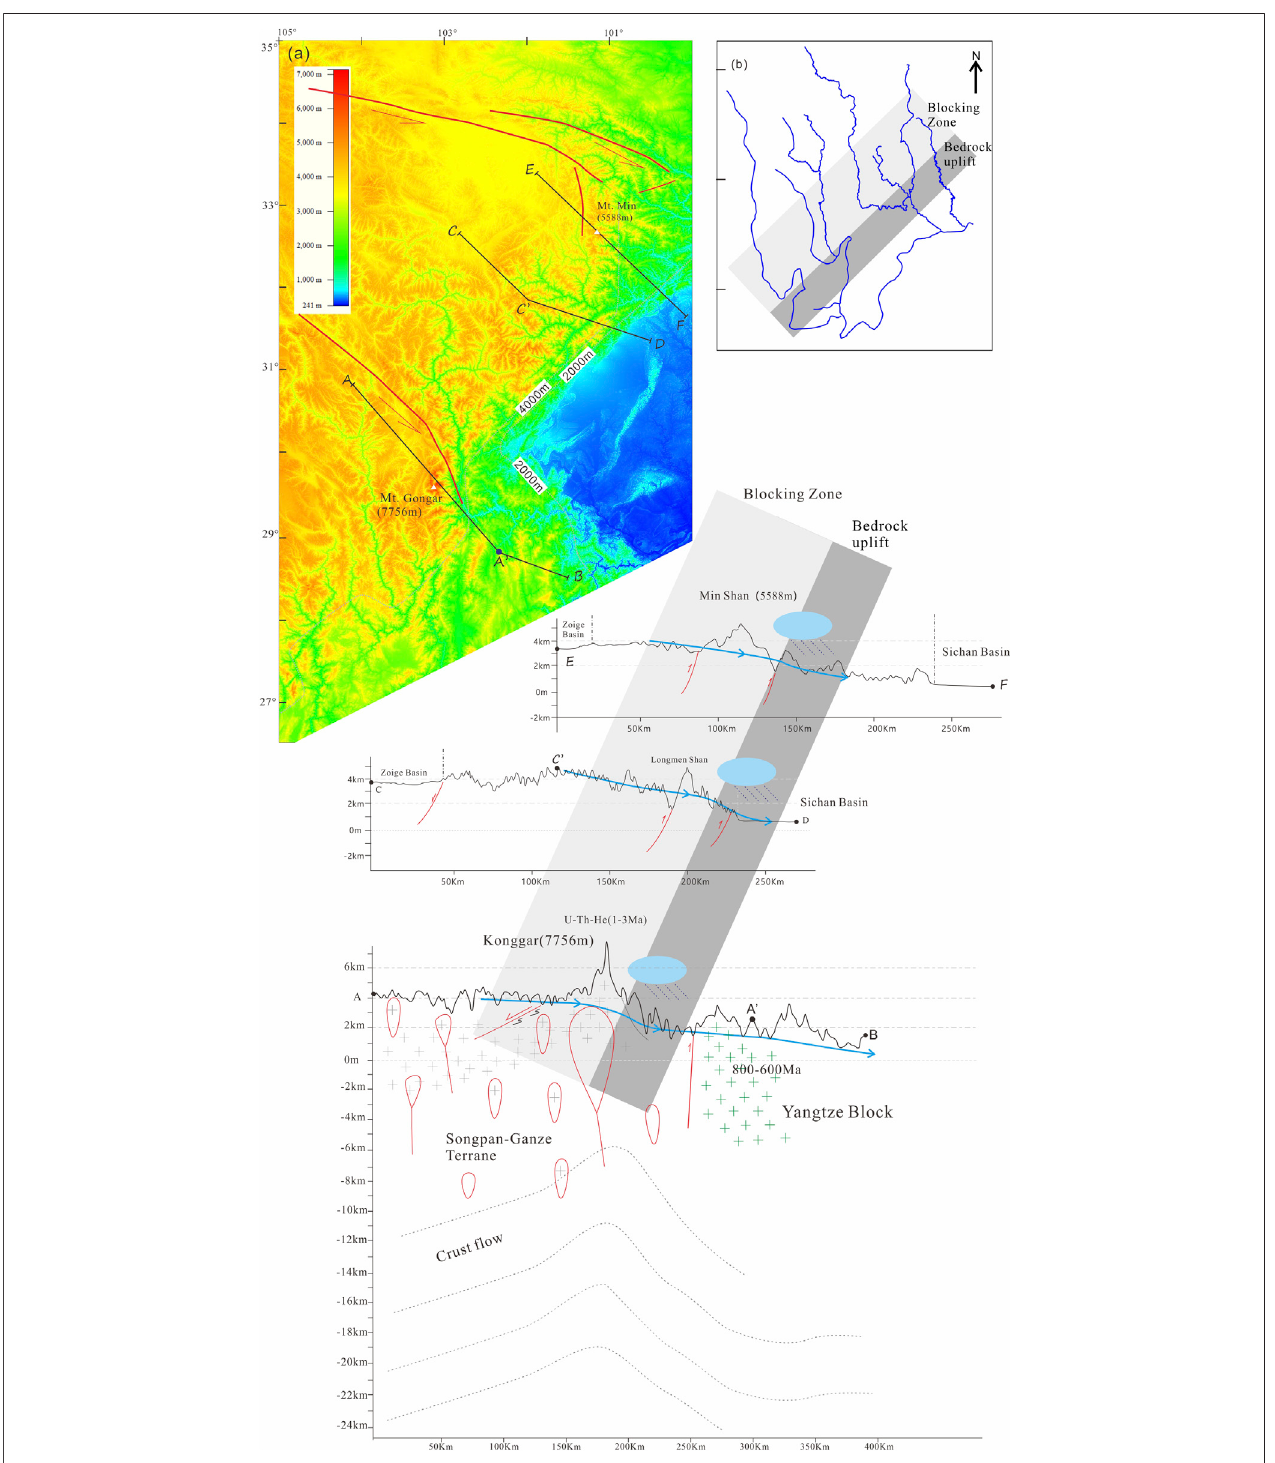
FIGURE7| Landform analysisoftheeastern TibetanPlateau(The map summarizesthecausesofthehigh and steeplandform onthe EastTibet.Theapproximate spatialpositionoftheblocking areaismarkedinthemap. Fromtheperspectiveofexogenicforces,heavy rainfallfrequentlyoccursinthepiedmont oftheeasternmargin of Tibet Plateau, which speeds up the denudation rate and makes an obvious contribution to high and steep landform. From the perspective of endogenic forces, three topographical sections are provided here. Pro fi le A-Bpasses through theGonggarmountain.Scholarsbelieve that there islowercrustal fl owin its deep part (Clark